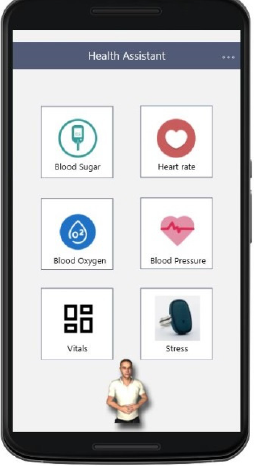
Figure 9. Home screen initial design prototype.